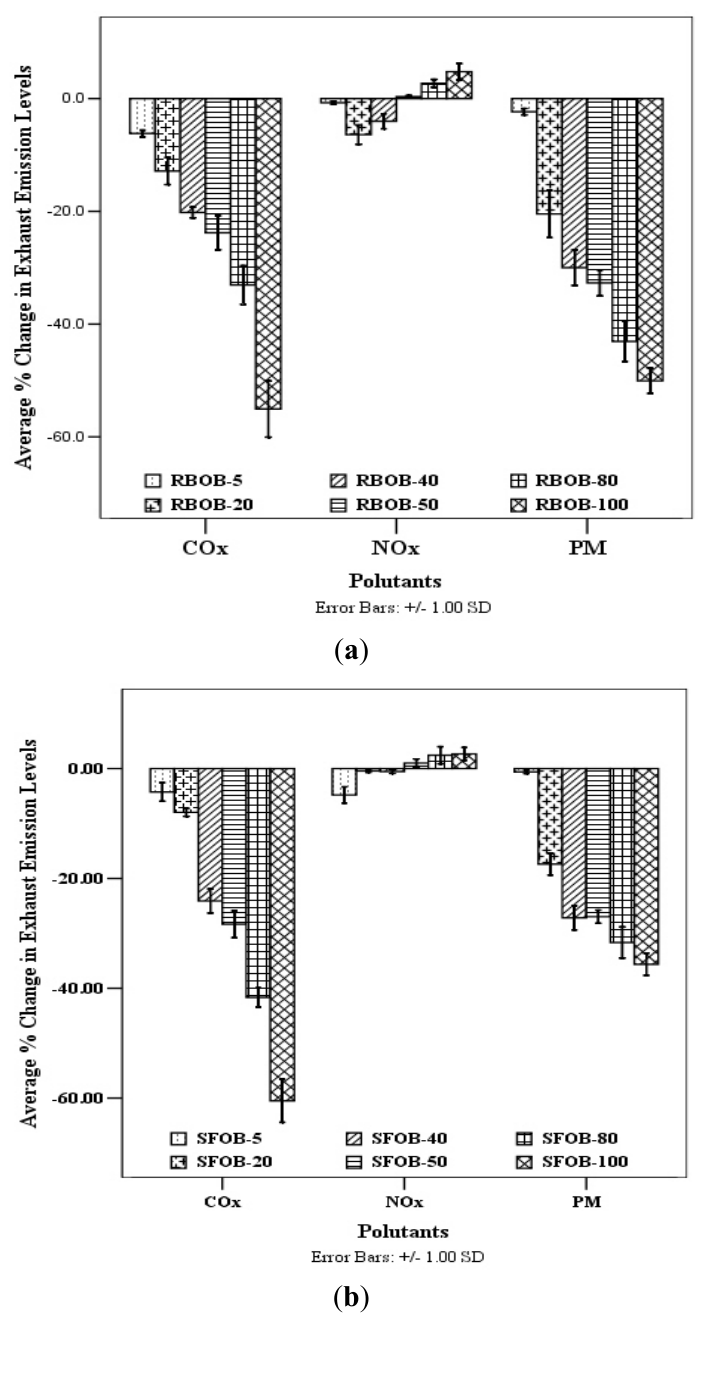
Figure 5. % change in exhaust emissions (CO, NO on ( a ) rice bran and ( b ) sunflower oils based biodiesel blends comparative to engine exhaust operated on conventional petro